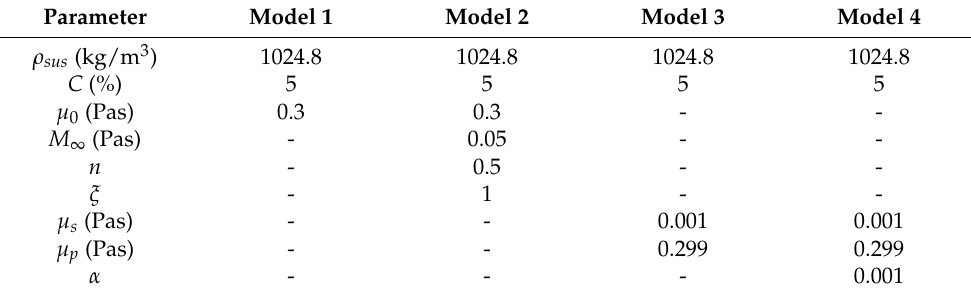
Table 2. Parameters used in the models